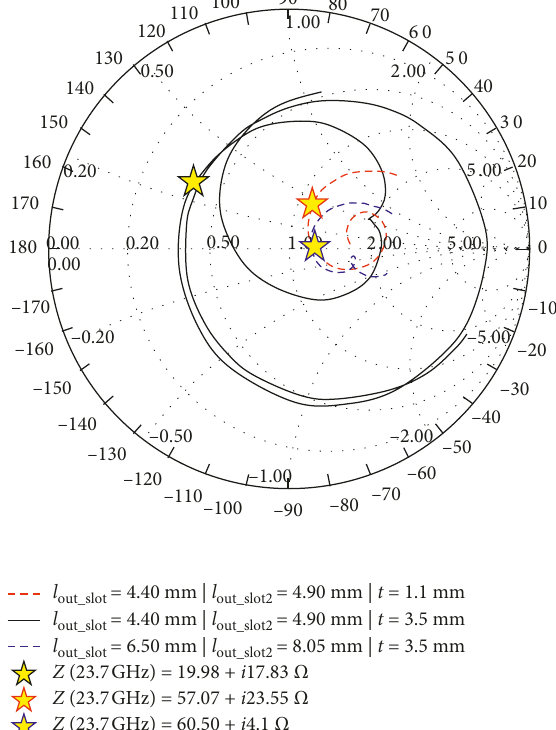
Figure 4: Smith chart analysis from 23.2 to 24GHz to demonstrate the effectiveness of the trapezoidal-shaped